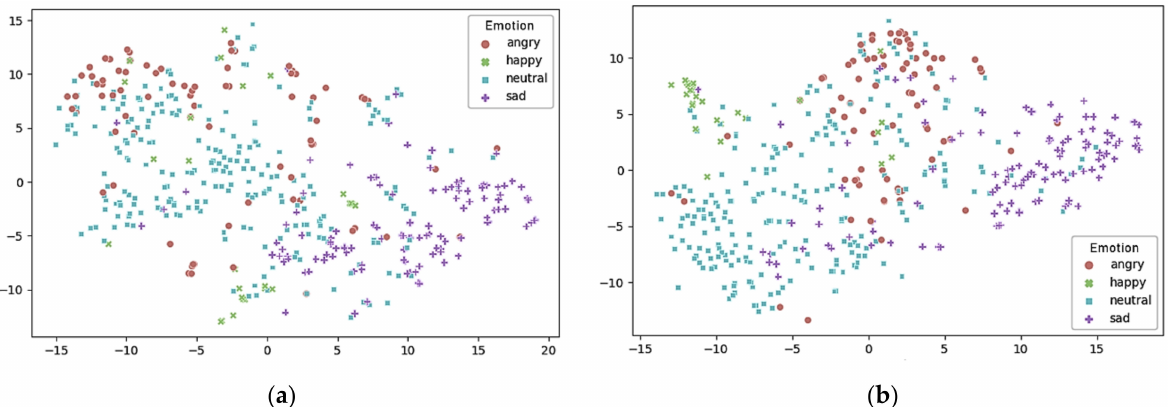
Figure 6. Distribution of reduced embedding vectors (the 64-D embedding vectors of the test data in the last fully-connected (FC) layer in the ensemble network) that are reduced to 2-D via t -stochastic neighbor embedding (t-SEN) dimension reduction: ( a ) embedding space for MPSL in Table 8b; ( b ) embedding space for MPGL in Table